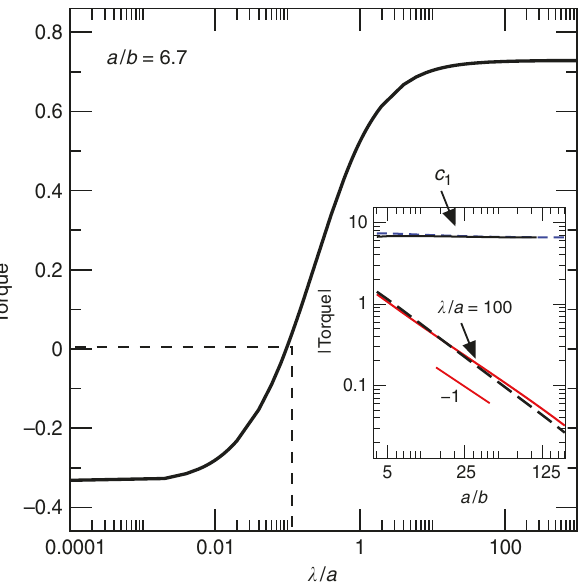
ffiffiffiffiffiffiffiffiffiffiffiffiffiffiffiffiffi Fig. 6 Torque versus hydrodynamic slip. Non-dimensional hydrodynamic : torque T = ð a 2 w _ γη Þ vs slip length λ / a for α = 0 and a / b = 6.7, based on full BI simulations. Dashed line marks the slip length when T changes sign. Inset: non-dimensional hydrodynamic torque vs aspect ratio for (i) a monolayer at α = π /2 ( c 1 ) when λ = 0 (full line) and λ / a = 100 (dashed line), and (ii) a monolayer (full red lines) and a bilayer (black-dashed lines) at α = 0 when λ / a = 100.